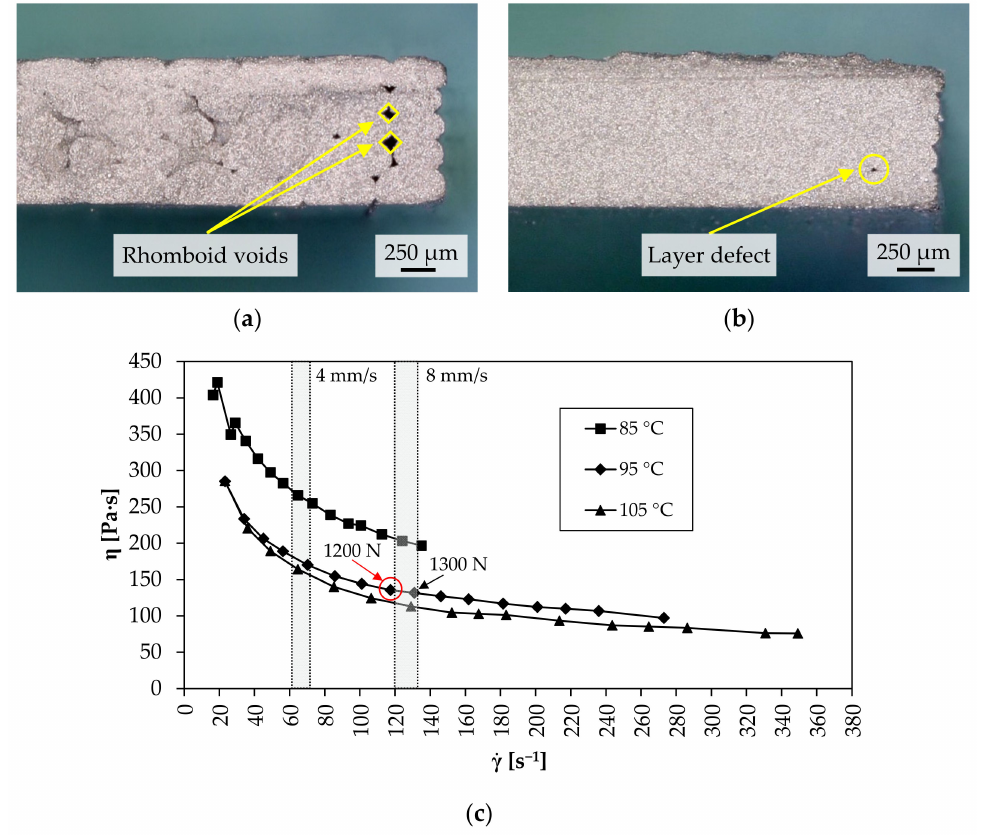
Figure 12. Digital images of fracture surface in z-x-plane of a test specimen printed at v = 8 mm/s and T = 95 ◦ C: ( a ) F e = 1200 N; ( b ) F e = 1300 N; ( c ) viscosity curves with gray highlighted shear rate range for dense green parts at v = 4 mm/s and v = 8 mm/s.